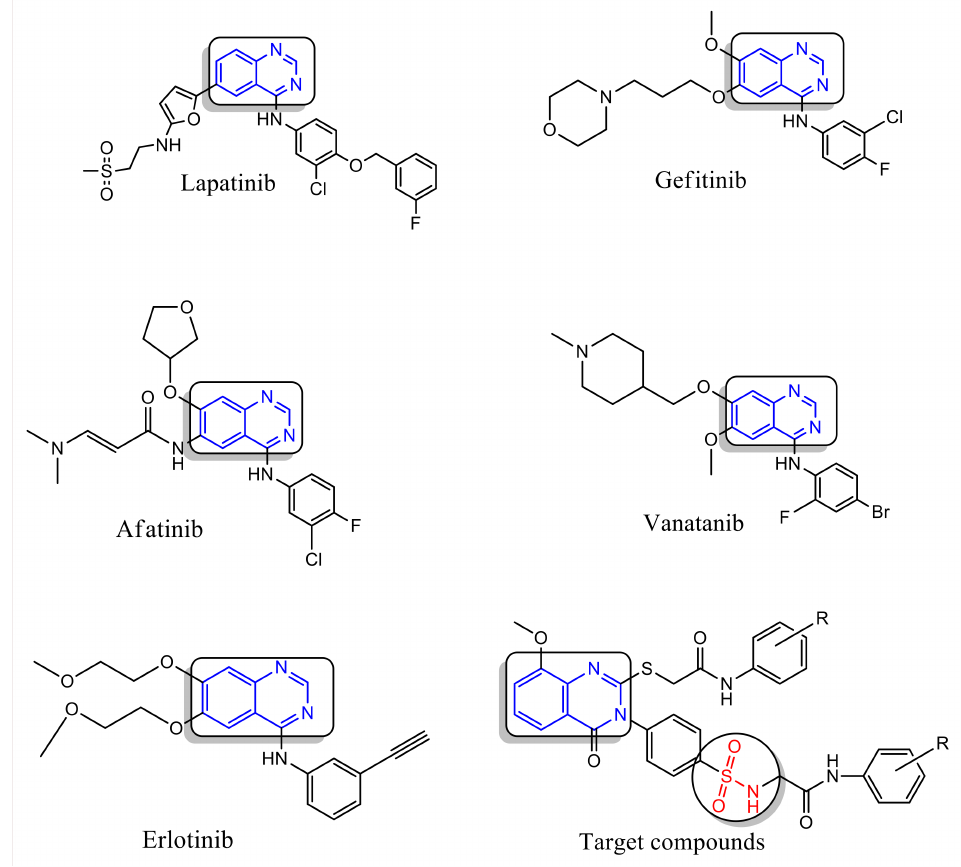
Figure 1. Quinazoline-containing